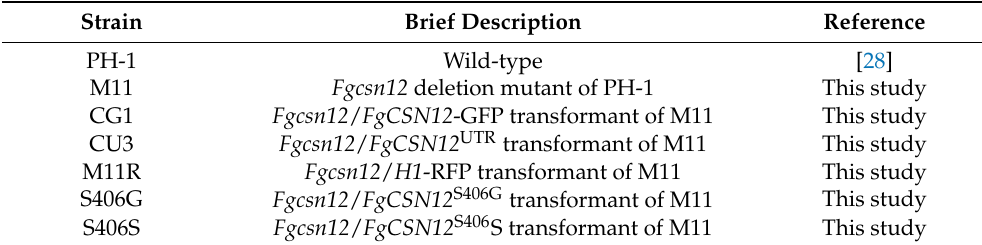
Table 1. The wild type and transformants of Fusarium graminearum used in this study.